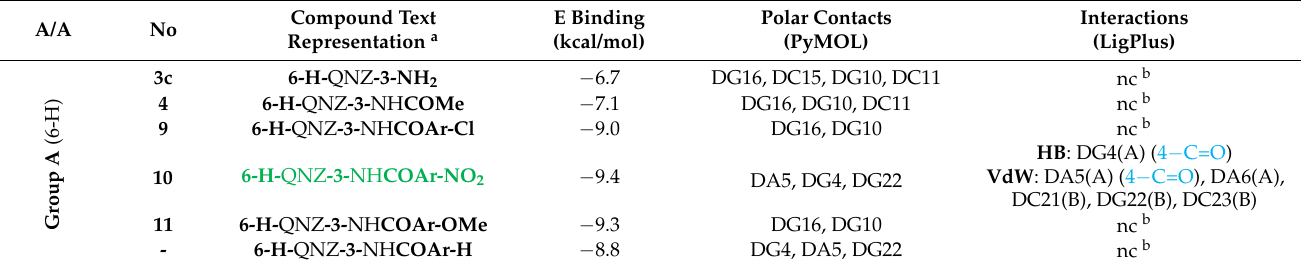
Table 1. Energy binding calculations towards DNA “in silico” of Group A.